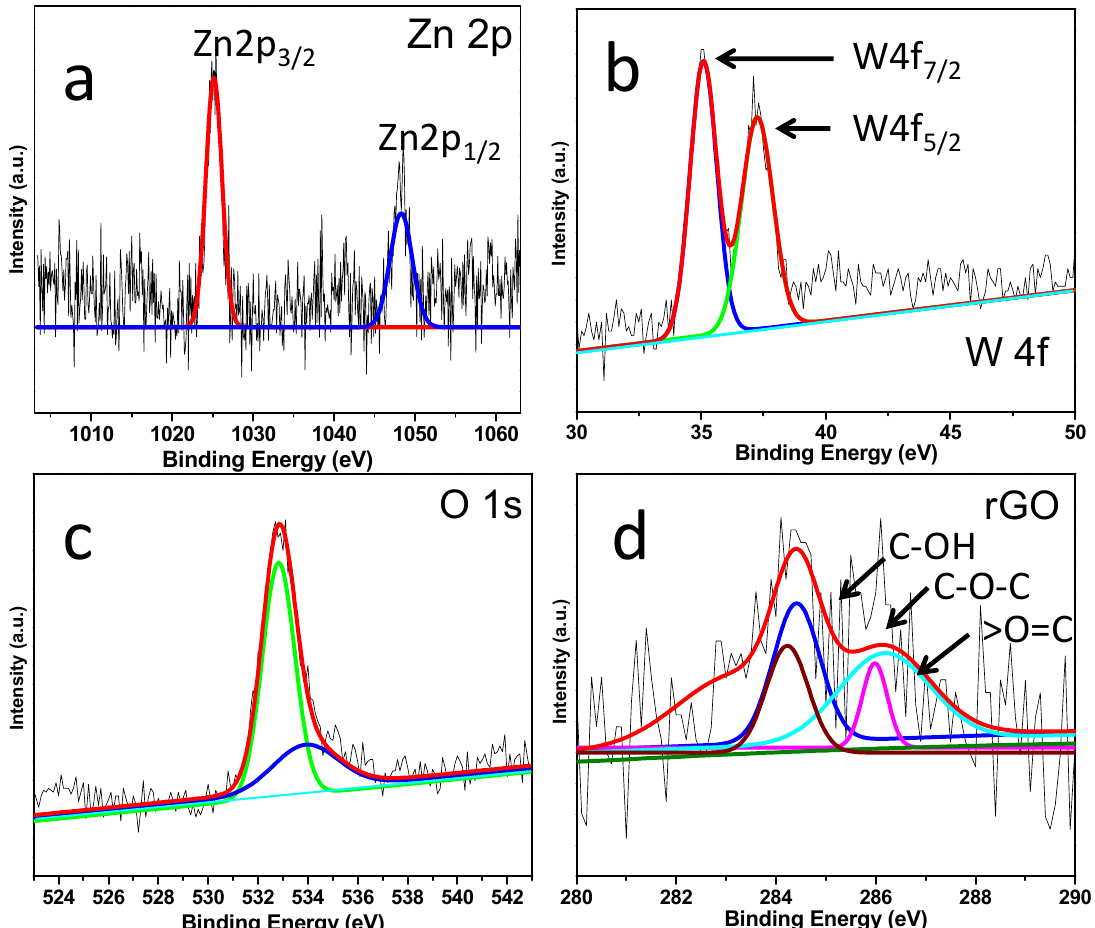
Figure 4. High-resolution XPS spectra of ( a ) Zn (2p), ( b ) W (4f), ( c ) O (1s), and ( d ) C (1s) in ZnWO 4 -NPs@rGO nanocom- posites.